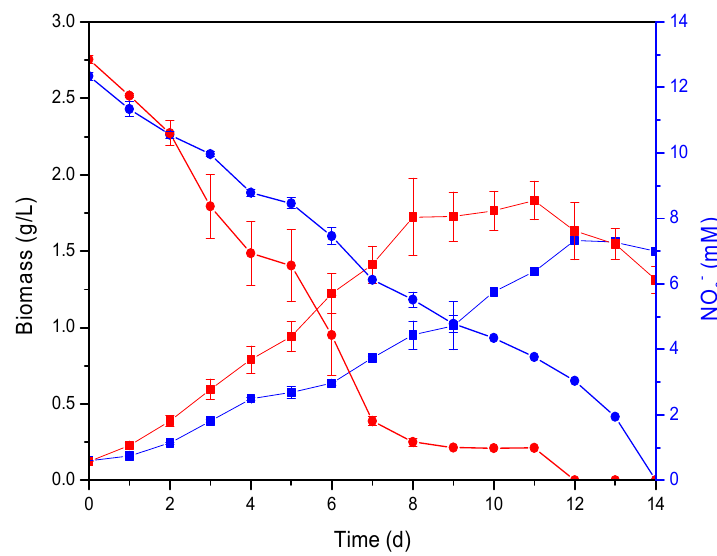
Figure 1. Growth curves (squares) and nitrate uptakes (circles) for cultures of Phaeodactylum tricornutum at different light:dark photoperiods: 12:12 h (blue symbols) and 18:6 h (red symbols). The growth rate was 0.24 and 0.33 d − 1 ( p -value = 0.01) for the 12:12 and 18:6 h light:dark